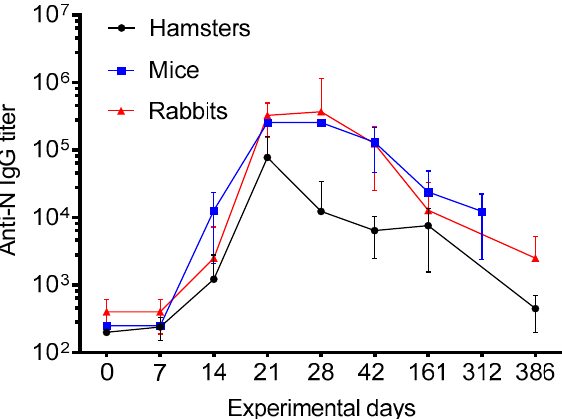
Figure 2. N-specific IgG titers ( y -axis: median values and Q1:Q3 ranges) measured in immunized mice (n = 5 per time point), hamsters (n = 5 per time point) and rabbits (n = 10 per time point). Animals were immunized on days 0 and 14.